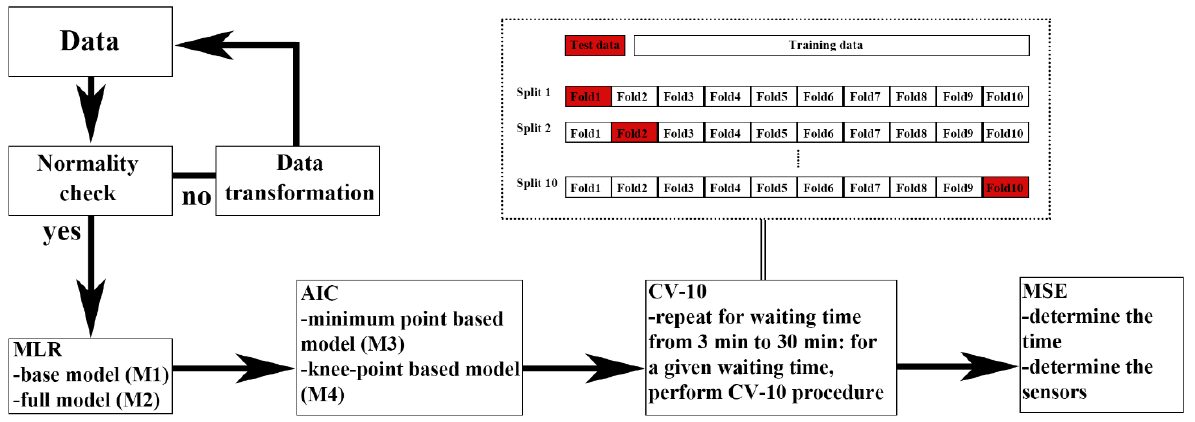
Figure 8. Flowchart for fitting and comparing the tsunami early warning models.